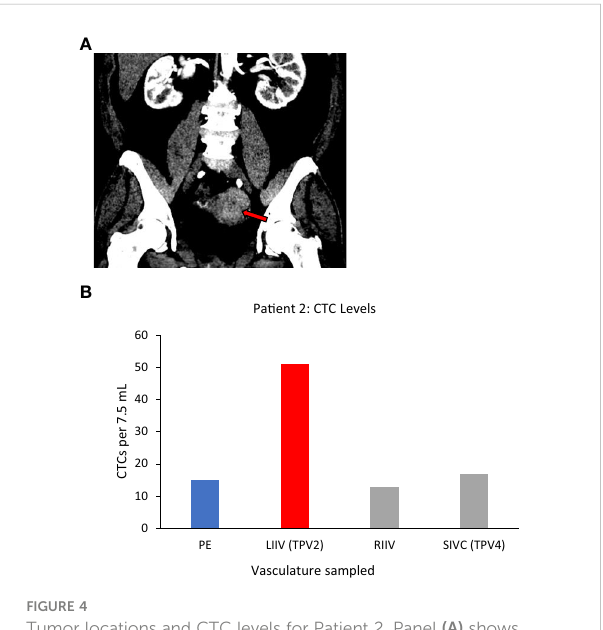
FIGURE 3 CTC levels in the tumor-draining/proximal and peripheral veins of Patient 1. The mean (n=2) value of circulating tumor cells (CTCs) detected in the portal vein, TDV1 of the PNET, was 419 CTCs per 7.5 ml compared with < 4 CTCs per 7.5 ml detected in any other vascular compartment sampled: right renal vein (RRV), left renal vein (LRV), splenic vein (SV), peripheral vein (PE). Please note that while RRV is the TPV1 for the patient ’ s other tumor, the renal cell carcinoma (RCC), these tumor cells were not ef fi ciently detected by the CellSearch assay; therefore, the numbers reported for this sample are likely an undercount. The y-axis is on a log scale.